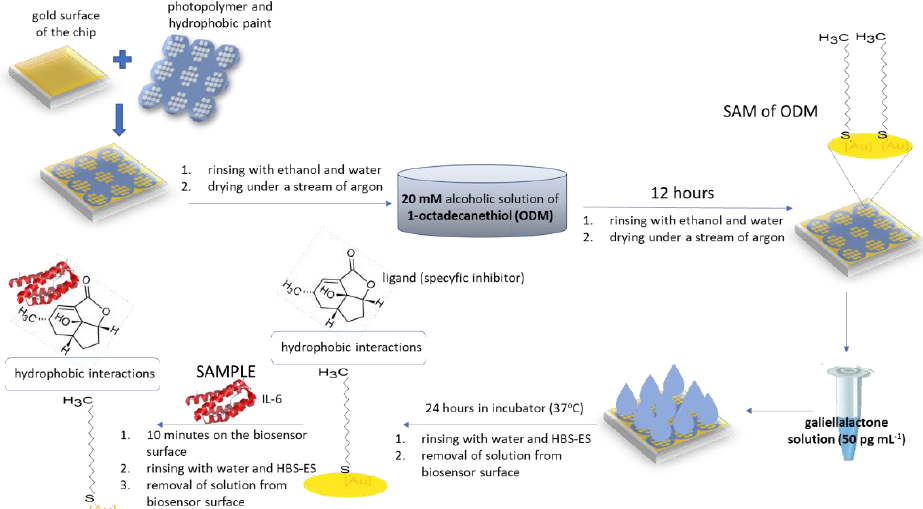
Figure 2. Workflow of the formation of a biosensor (i) with galiellalactone as the